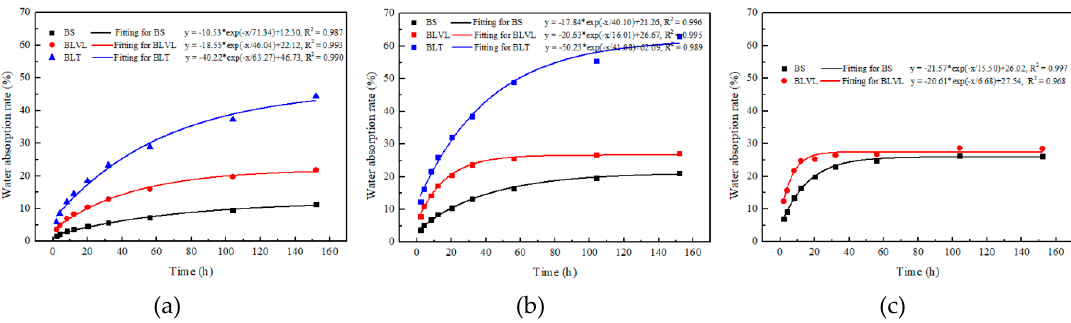
Figure 3. Water absorption rate and model prediction of three types of bamboo composites under different hydrothermal aging temperatures. ( a ) Aging temperature at 23 °C ; ( b ) Aging temperature at 63 °C ; ( c ) Aging temperature at 99 °C.